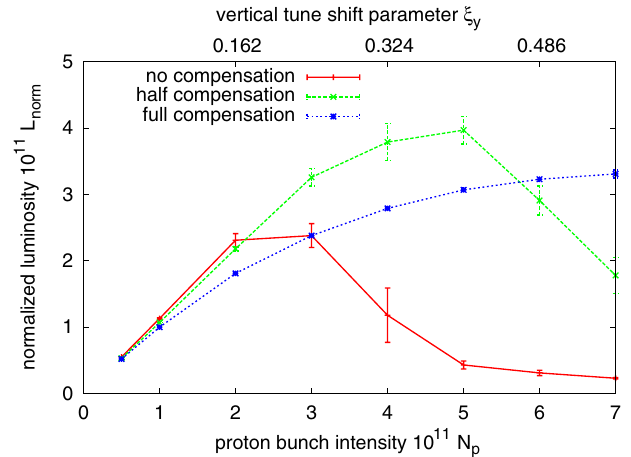
FIG. 12. (Color) Maximum normalized luminosity obtained dur- ing tune scans as a function of the proton bunch intensity N p , for half compensation N e =N p ¼ 0 : 5 . The cases for zero ( N e =N p ¼ 0 ) and full ( N e =N p ¼ 1 : 0 ) compensation are shown for com- parison, and are identical to those shown in Fig.